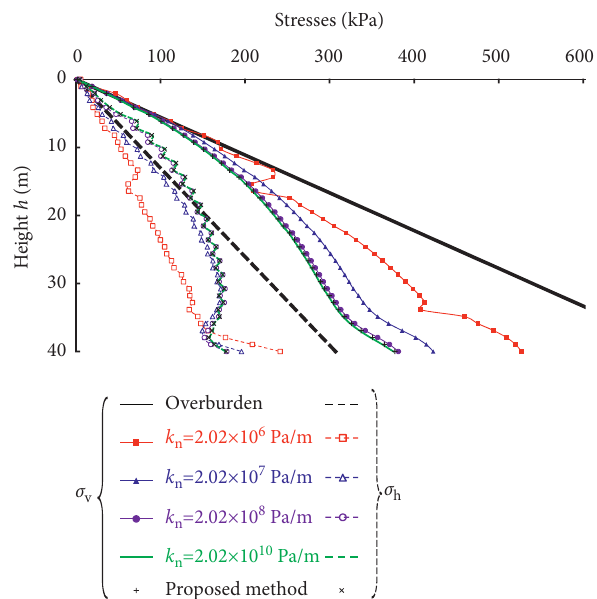
Figure 5: Vertical ( σ v ) and horizontal ( σ h ) stresses plotted along VCL of stopes with different normal stiffness (k) n of interfaces in upward cut and fill mining.